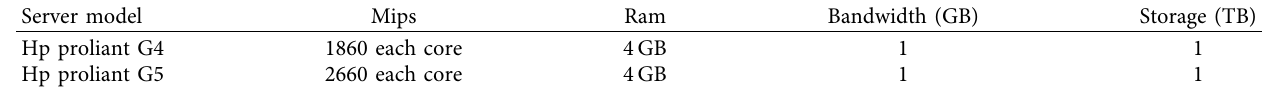
Table 3: Specifications of the servers evaluated.